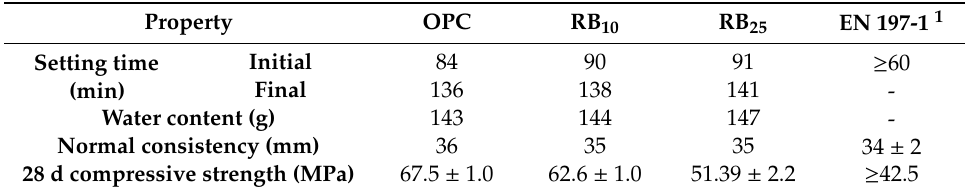
Table 1. Fresh properties in binders.